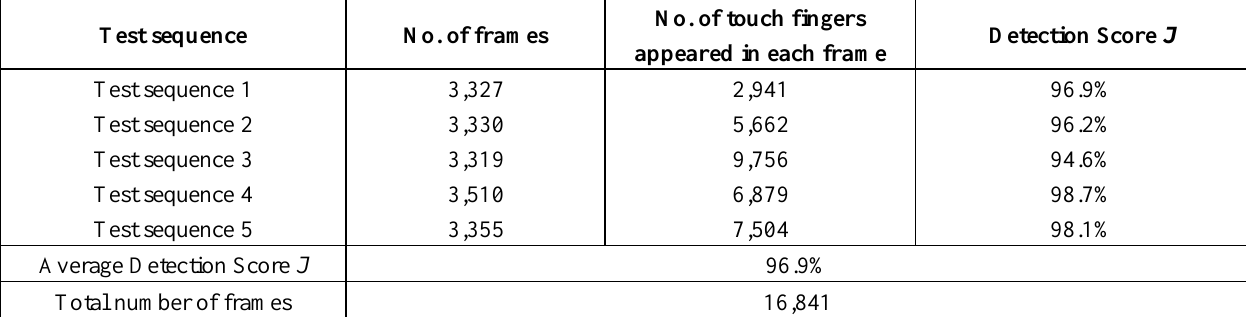
Table 1. Experimental data of the proposed approach on touch finger detection performance. Test